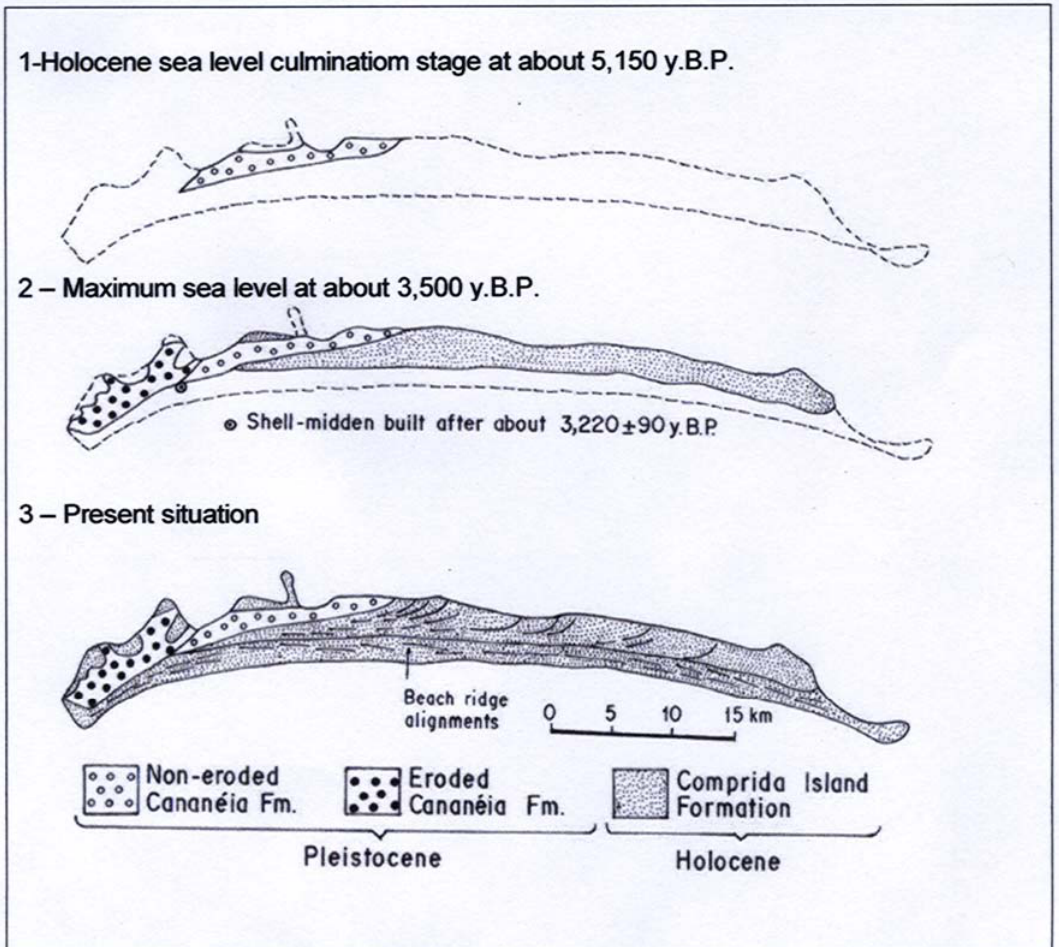
Fig. 2 – Comprida Island evolutionary scheme, during the Holocene, according to Martin and Suguio